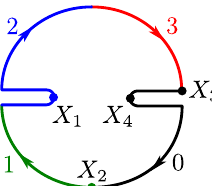
Figure 3 . Graphic representation of a single term in (3.25). In this example, s = 4 (with the replicas labeled 0 , 1 , 2 , 3 ), k = 1 , j = 0 , l = 2 , and t 2 = t 3 = 0